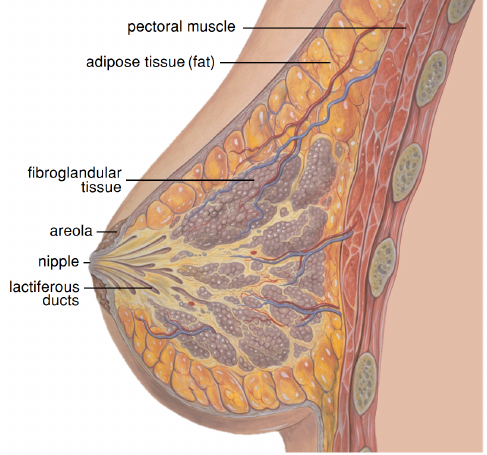
Figure 1. Breast anatomy: fibroglandular and fat tissues, which have distinct mechanical properties, compose most part of the breast - adapted from